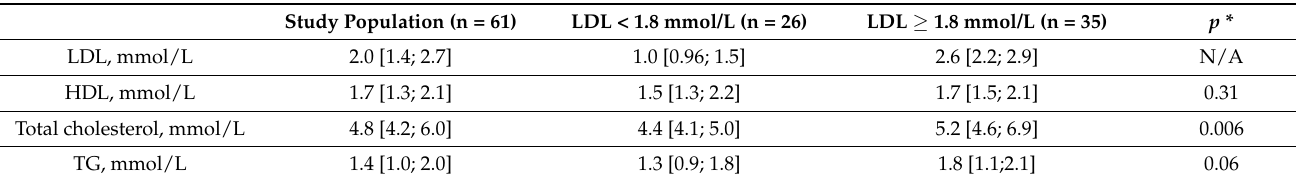
Table 2. Lipid profile of the study